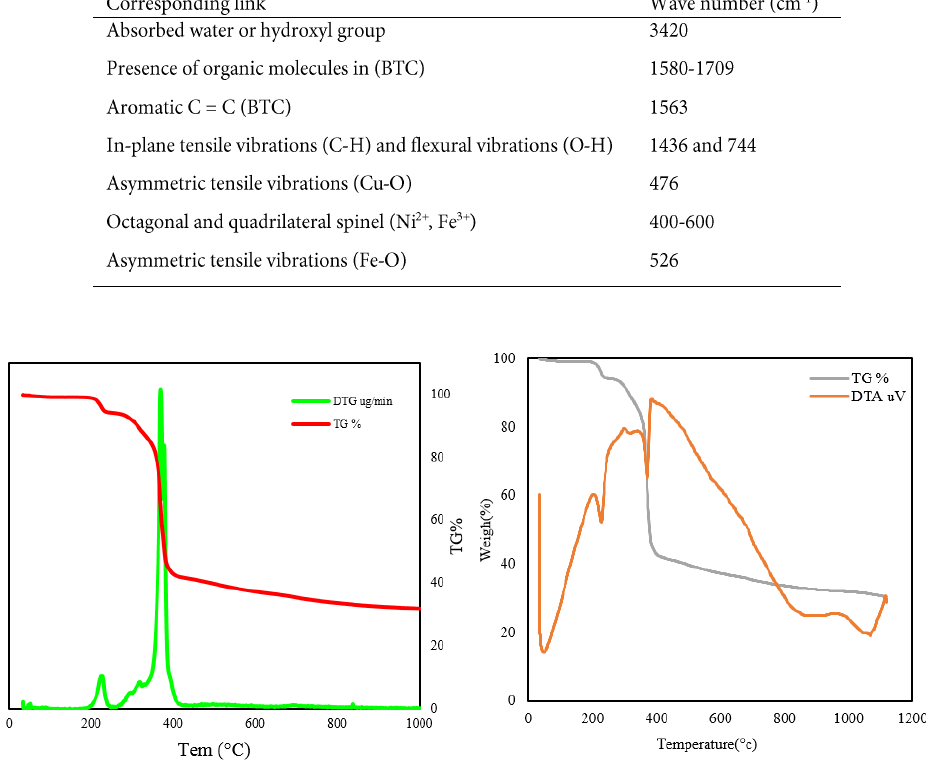
Fig. 6. thermal analysis of TG, DTA, and DTG for magnetic metal-organic framework sample NiFe 2 O 4 @SiO 2 @HKUST-1 with 30% (weight)